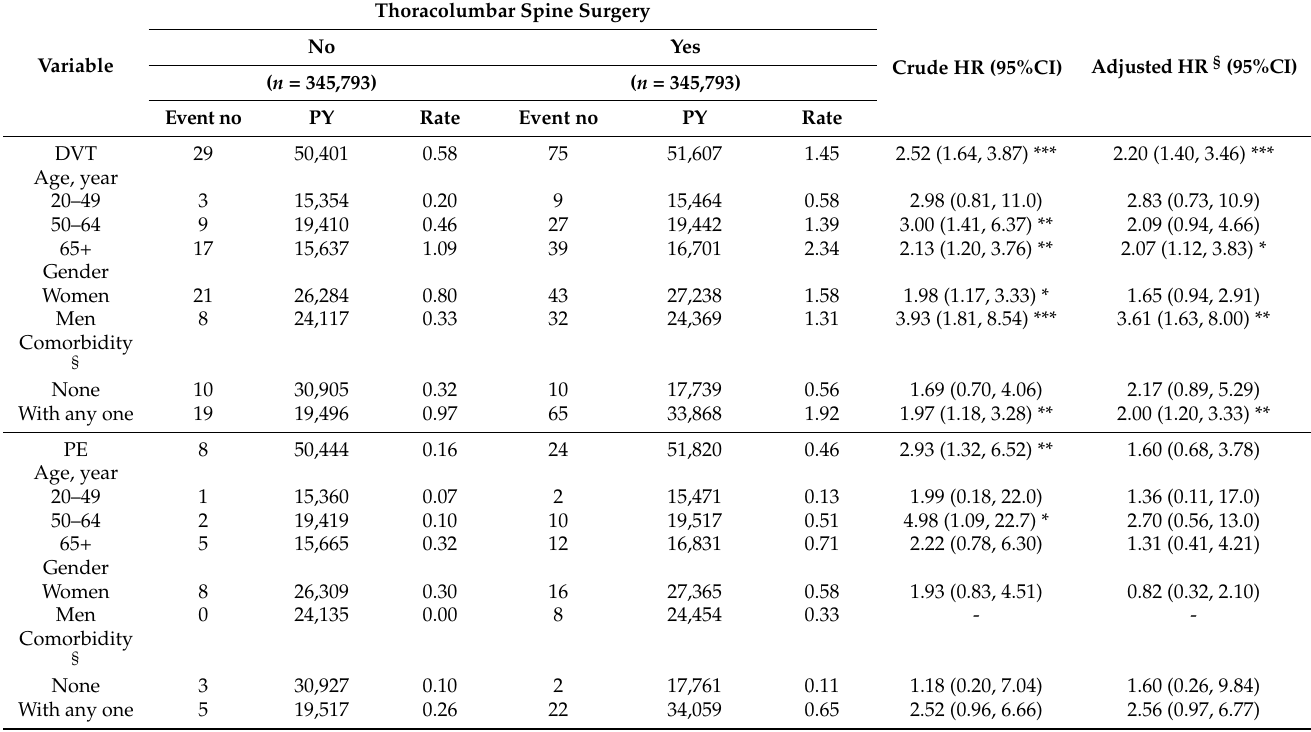
Table 3. Incidence and hazard ratio for DVT and PE stratified by age, gender, and comorbidity for patients with thoracolumbar spine surgery compared to those without thoracolumbar spine surgery.